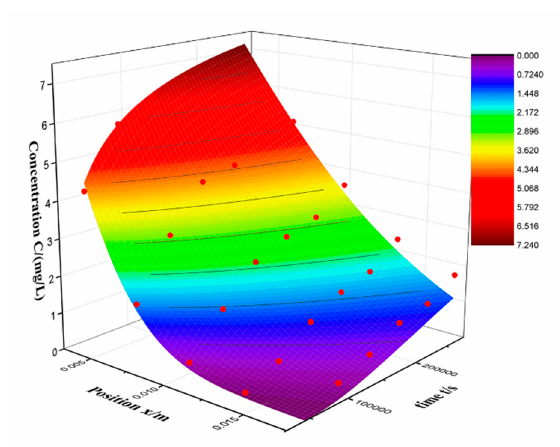
Figure 5. Inward di ff usion original experimental data-fitting surface. Figure 5. Inward diffusion original experimental data-fitting surface.